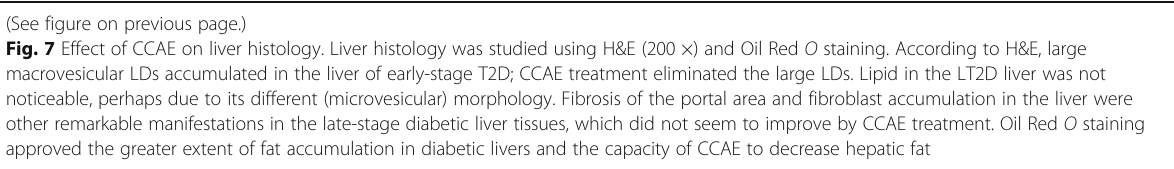
Table 4 Summary of the study items and the results Measured parameters ET2D LT2D CCAE effect on short-term blood sugar (IPGTT) ↑ ↓ ↑↑ – Extent of impaired glucose tolerance (AUC in IPGTT) ↑ NA Measured parameters on day 28 FBS HbA1c Hepatic PCC G6Pase mRNA PEPCK mRNA CPT1 Hepatic